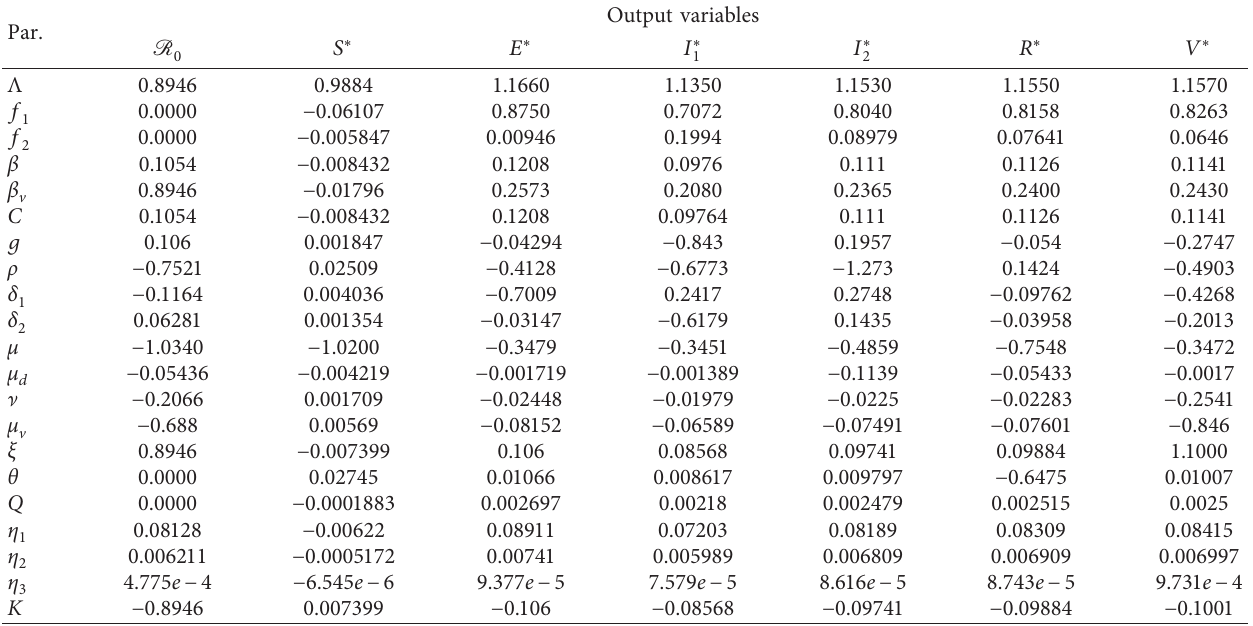
and ε ∗ with respect to model parameters. 0